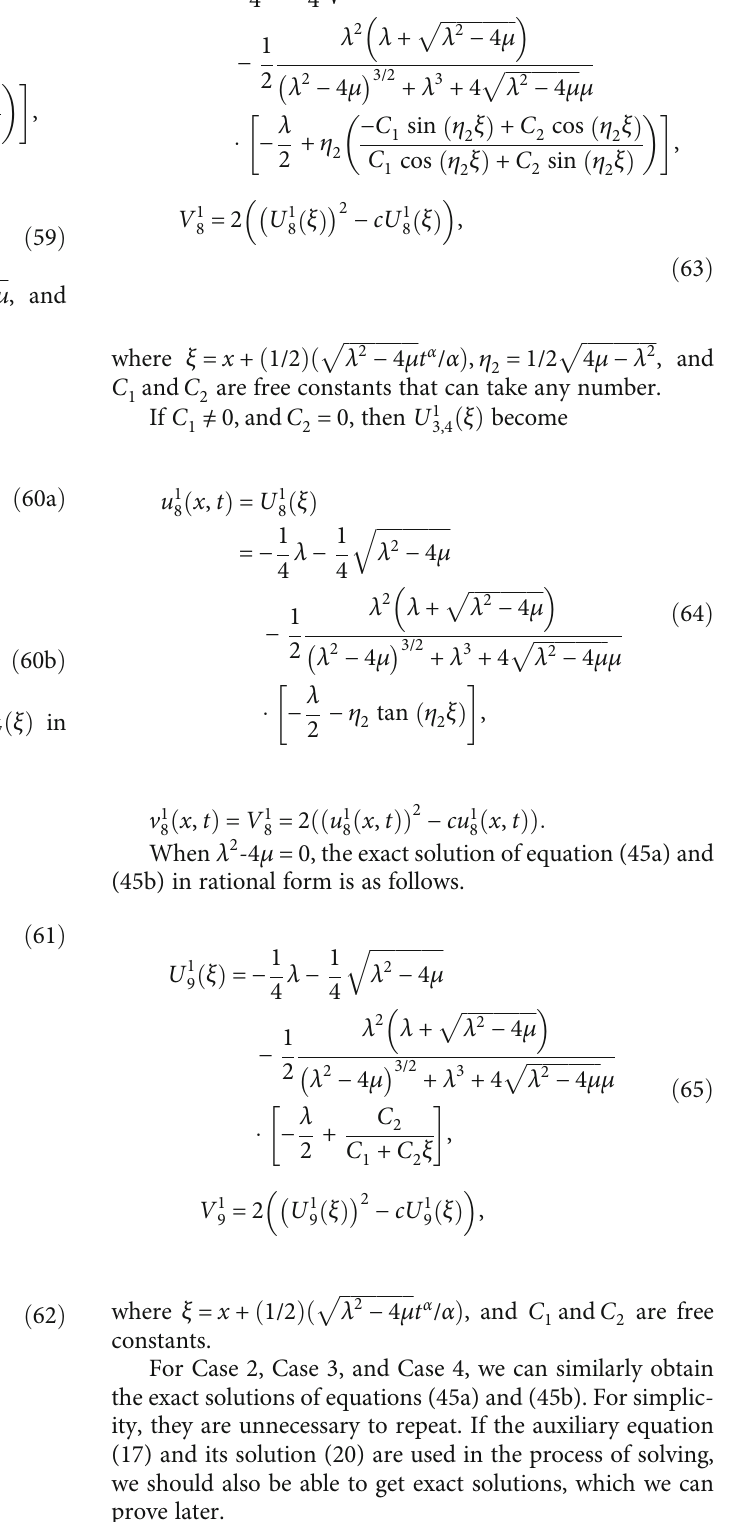
ffiffiffiffiffiffiffiffiffiffiffiffiffiffiffi p(cid:4)